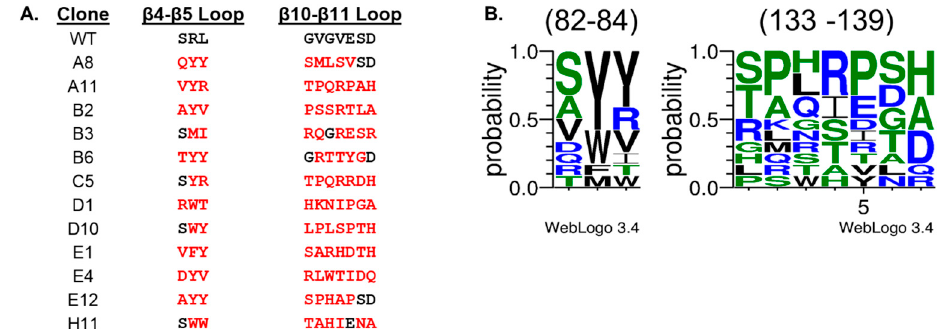
Figure 3. Amino acid sequence analysis of two loops randomized in the phage-displayed scaffold. ( A ) Primary sequences of the wild-type (WT) form of the scaffold and 12 variants that bind the Akt1 phosphopeptide. Three and seven residues in the β 4- β 5 or β 10- β 11 loops, respectively, were randomized with NNK codons, where N is an equimolar mixture of A, C, G and T and K is an equimolar mixture of G and T. Residues that differ from the wild-type sequences are show in red. ( B ) WebLogo plots of the frequency of particular residues at each position (82–84 or 133–139). The height of a residue refers to probability of the residue at the given position. Hydrophobic, polar, and charged residues are shown in black, green, and blue, respectively.